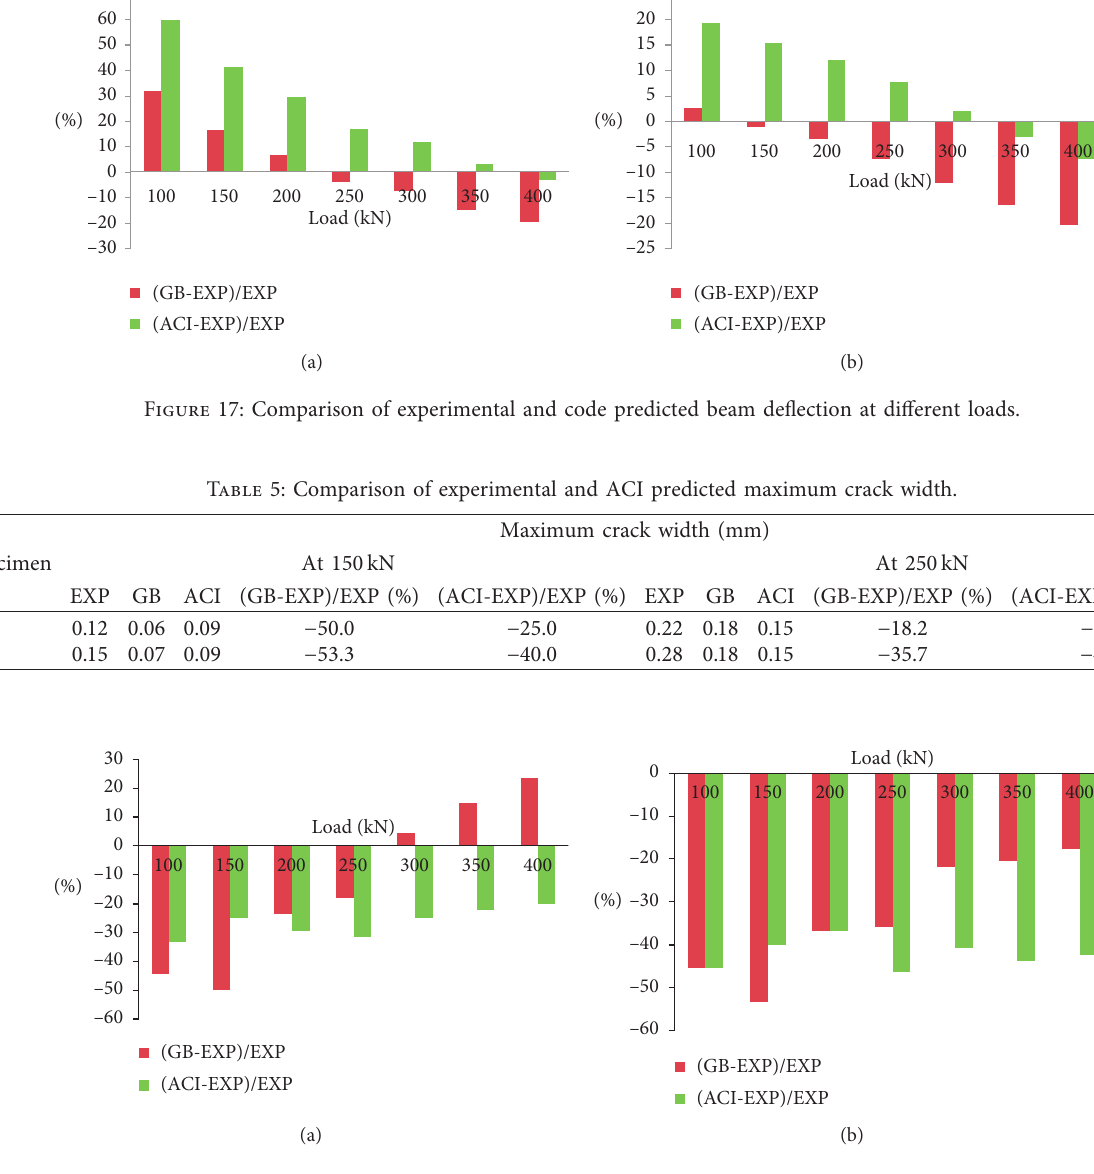
Figure 18: Comparison of experimental and ACI predicted maximum crack width at different loads: (a) JD1; (b)